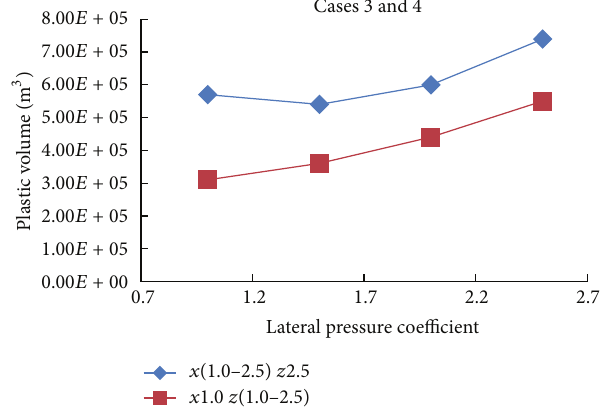
Figure 18: Plastic volume versus lateral pressure coefficient in cases 3 and 4